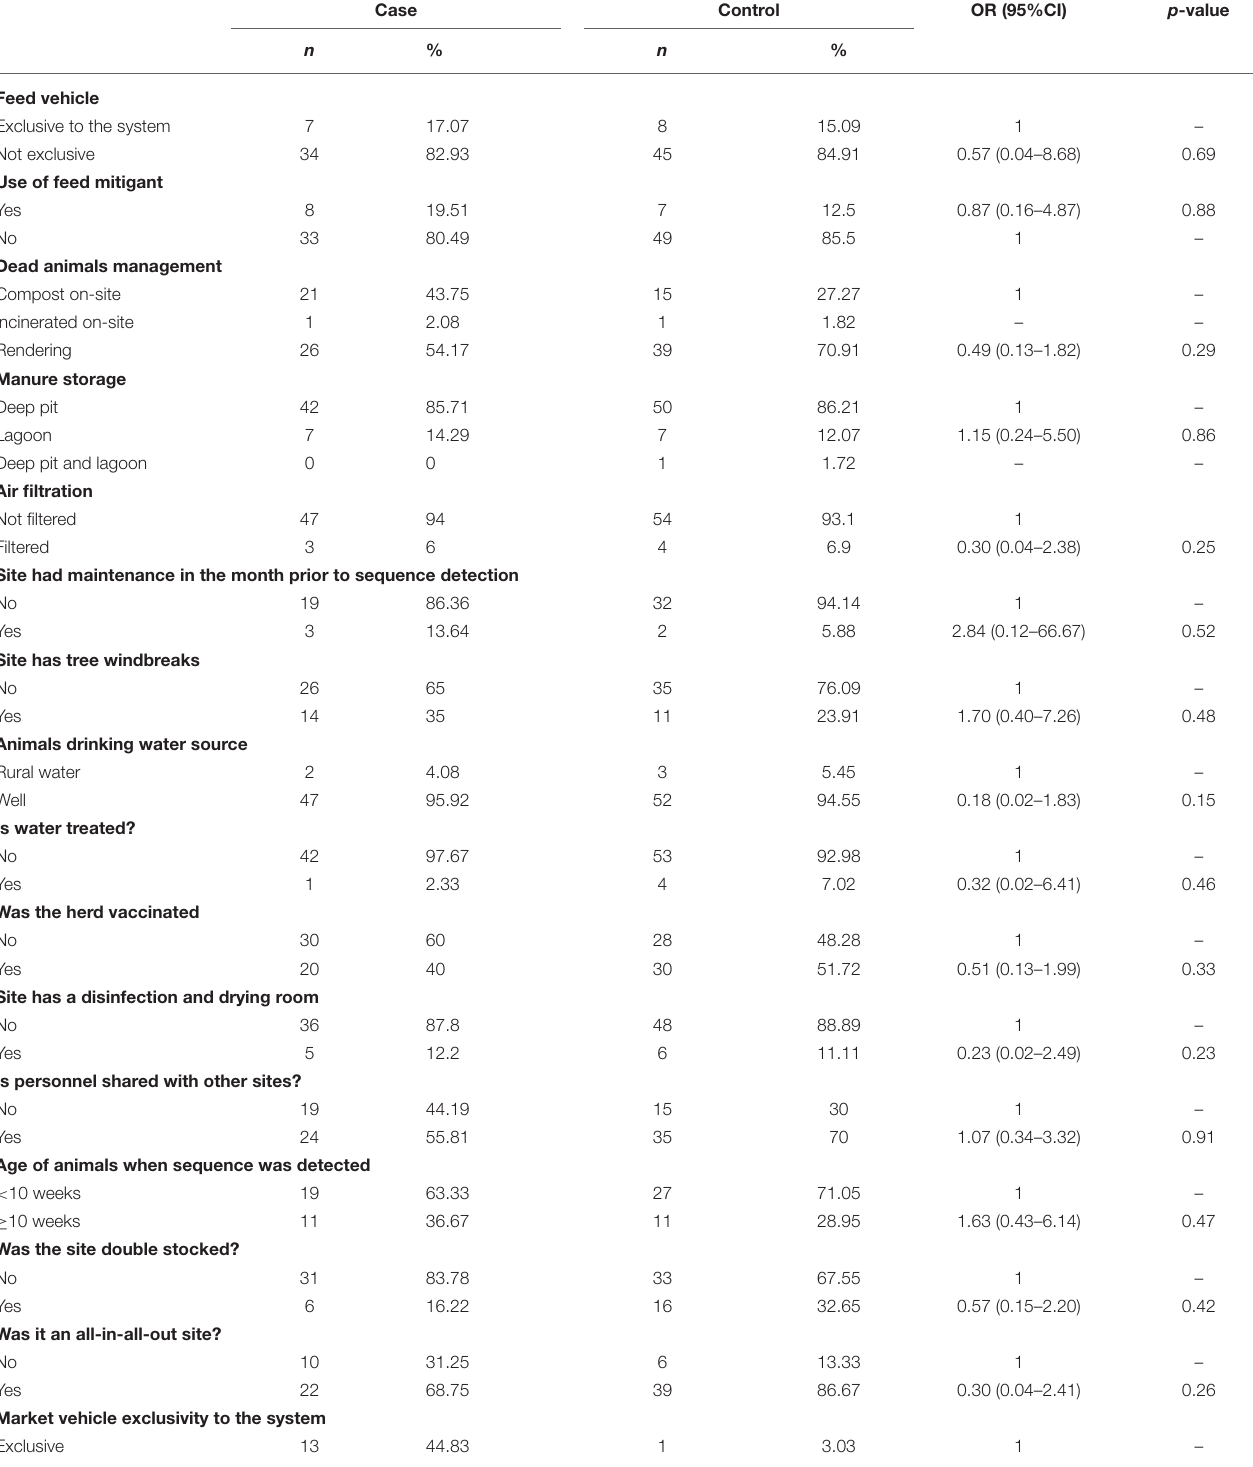
TABLE 2 | Factors associated with PRRSV transmission between within herd outbreaks caused by the newly emerging Lineage 1C variant (cases) and other PRRSV variants (controls). Case Control OR (95%CI) p -value n %